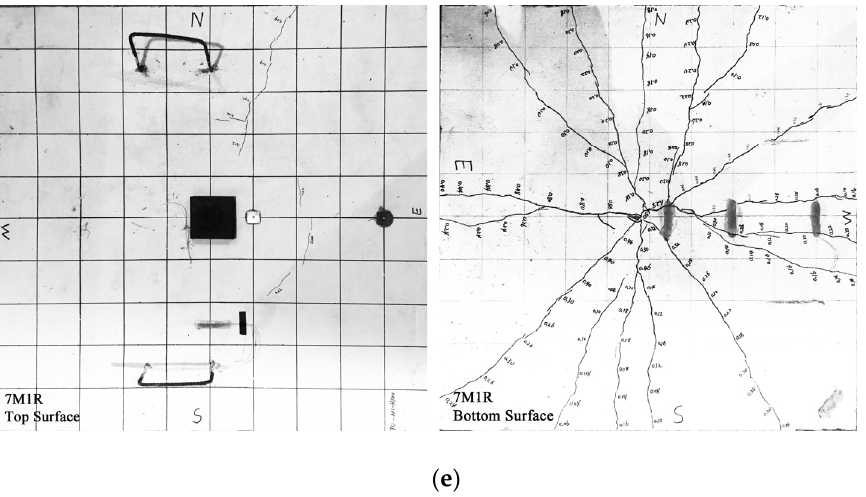
Figure 9. Sketched cracks profiles of the ( a ) 6MR specimen, ( b ) 7MR specimen, ( c ) 8MR specimen, ( d ) 7MN specimen, and ( e ) 7M1R specimen.